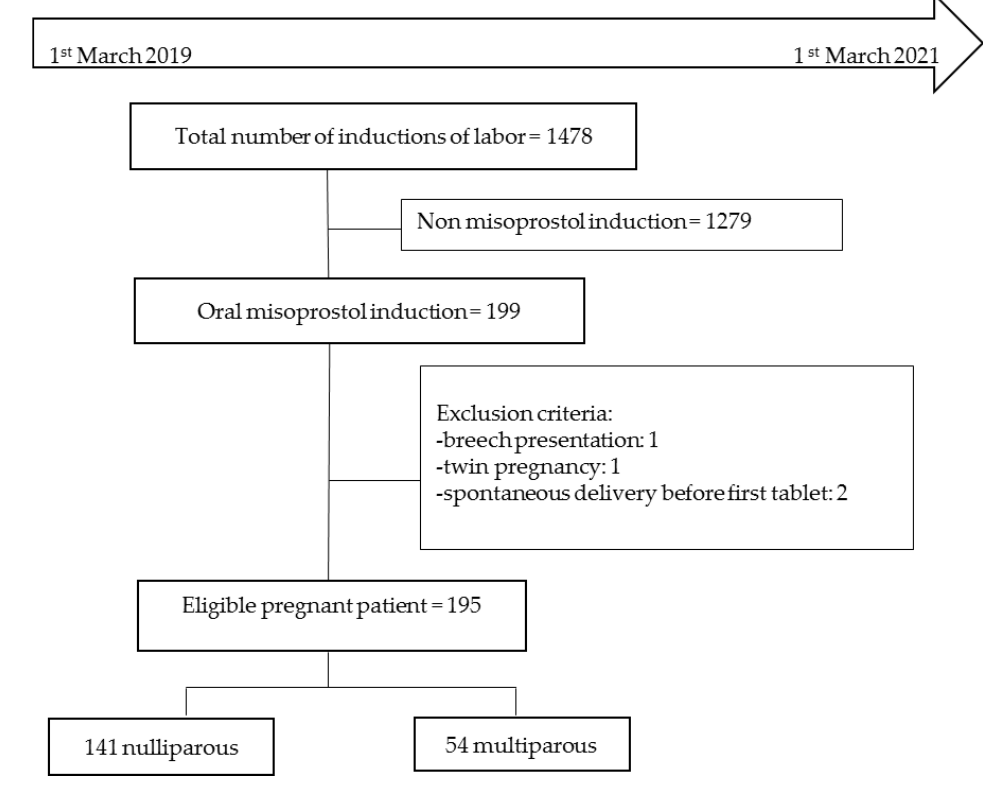
Figure 1. Flow chart .